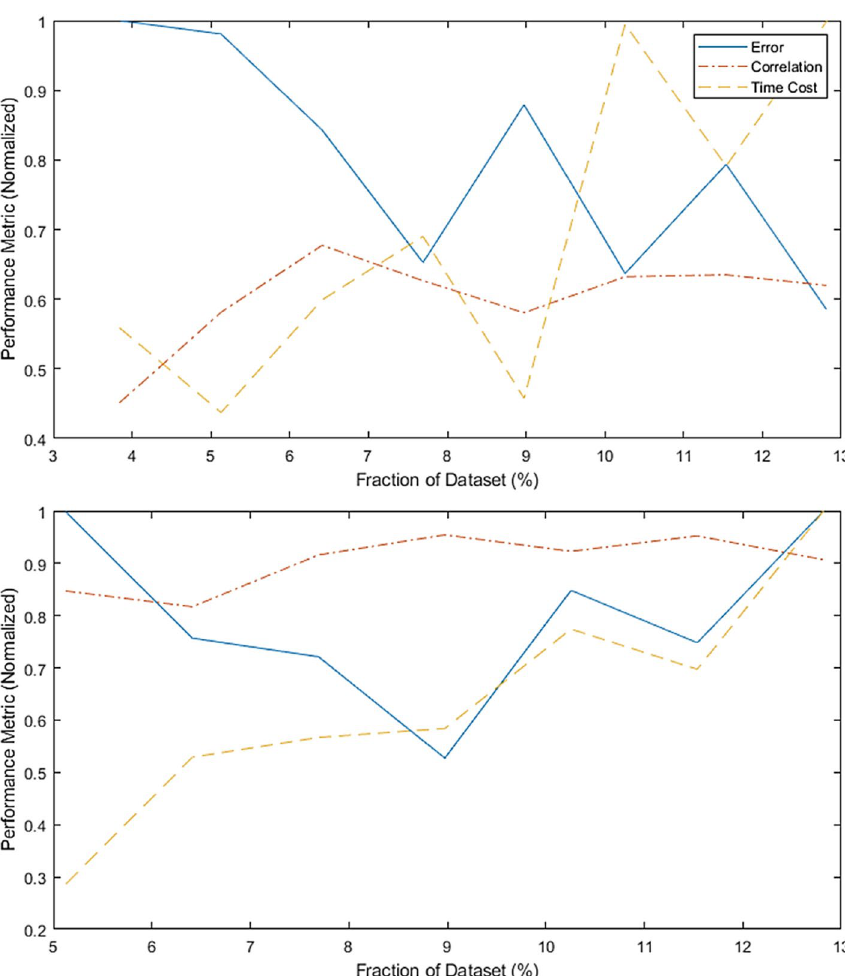
Figure 3. Reconstruction performance of matrix decomposition without clustering (top) versus that of the proposed ensemble (size 5) approach with ensemble SOM clustering layers (bottom) with respect of available information and missing information (matched). The simulations are carried out with respect to the critical latent space size (50%). Fitness, error and computational cost versus the latent space size are reported. Both error and computational cost are normalized with respect to their respective highest values in the simulations. The validation results are intended to clearly show that a search for an optimal sample size of the master set is significant for an improved CIC performance. This is shown by the U-shaped performance in the bottom sub-